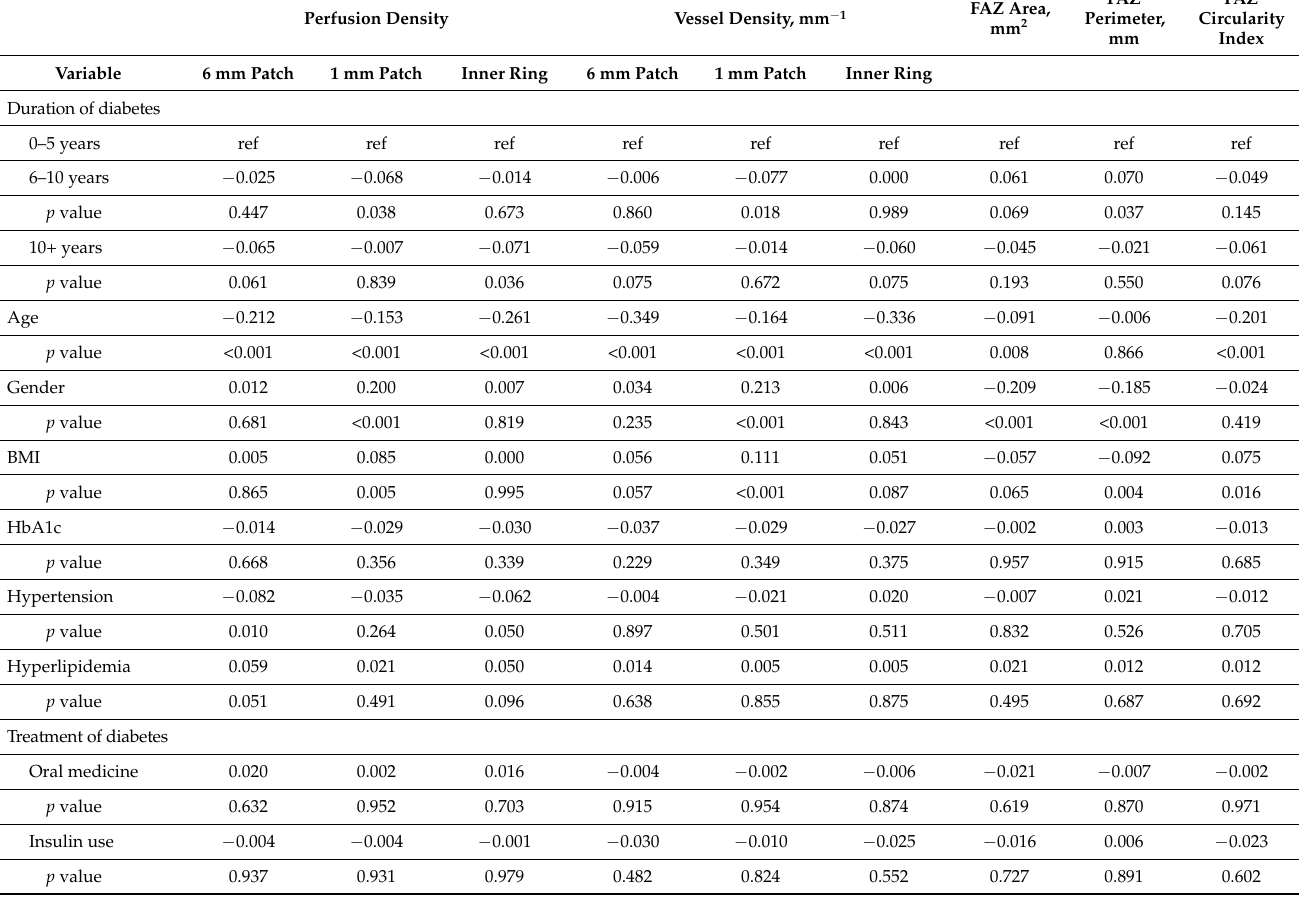
Table 3 shows the results of multivariate linear regression analysis. There were strong associations between age and all OCTA parameters except FAZ perimeter. In addition, there were strong associations between sex and SPD 1 mm patch, SVD 1 mm patch, FAZ area and FAZ perimeter. A diabetes duration of 6–10 years was significantly associated with SPD 1 mm patch, SVD 1 mm patch, and FAZ perimeter. A diabetes duration of over 10 years was weakly associated with SPD inner ring. Table 3. Standardized Coefficients for Association of Demographic and Clinical Variables with OCTA Density and Foveal Avascular Zone (FAZ) Parameters. FAZ Perfusion Density Vessel Density, mm − 1 FAZ Area, mm 2